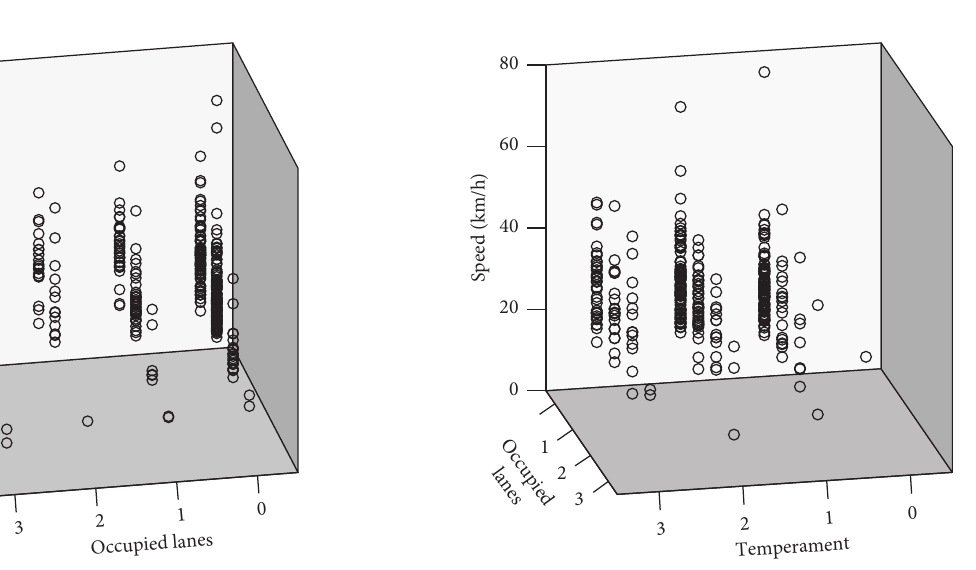
Figure 10: Relationship between temperament, traveling speed, and illegal lane occupation behavior.